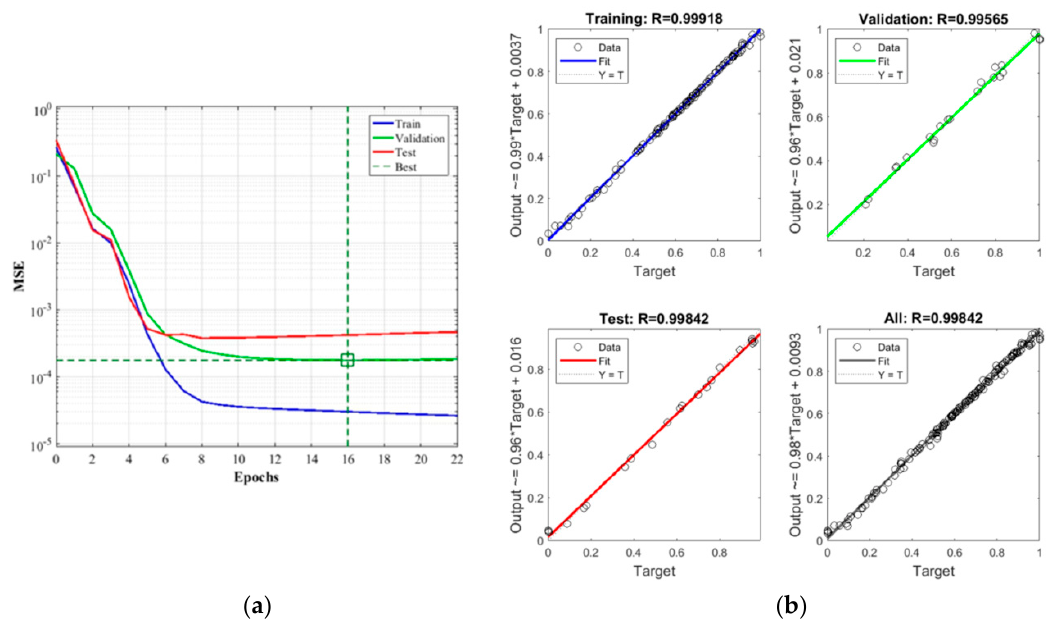
Figure 11. Training results of error approximation ( a ) and the fitting ( b ) for the 5-2-12-3 ANN model. Table 5. Weights of established ANN model.